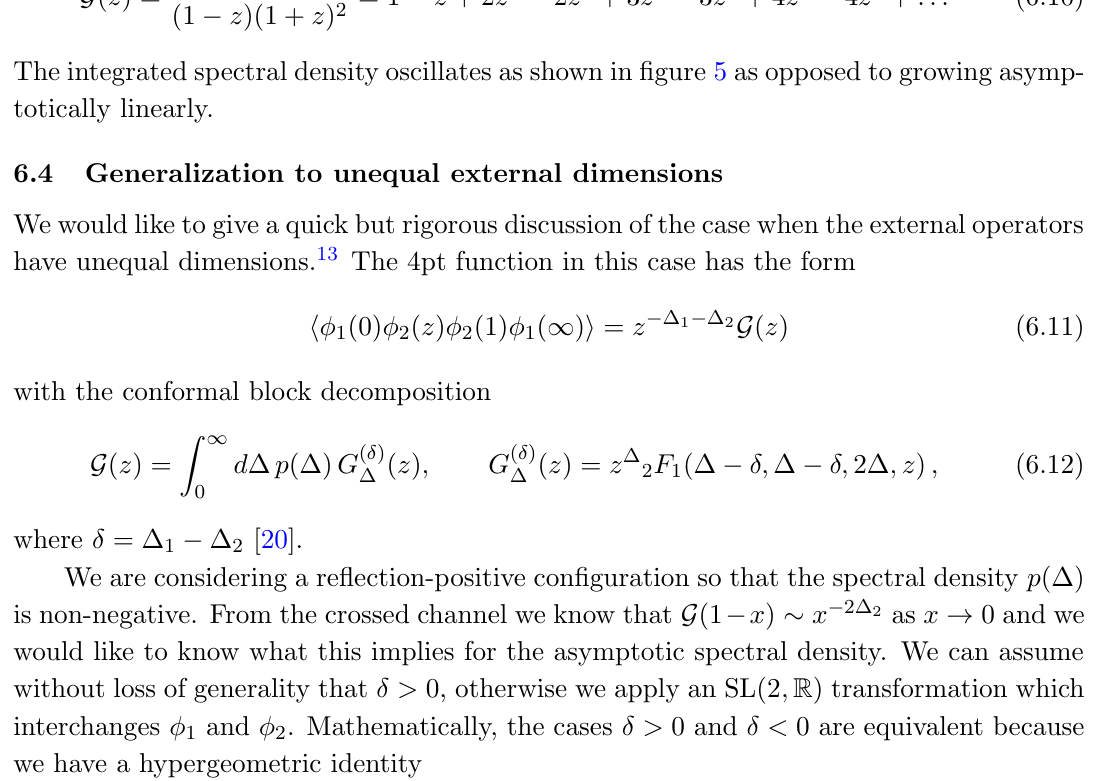
d (cid:1) r ((cid:1)) corresponding to the series 0